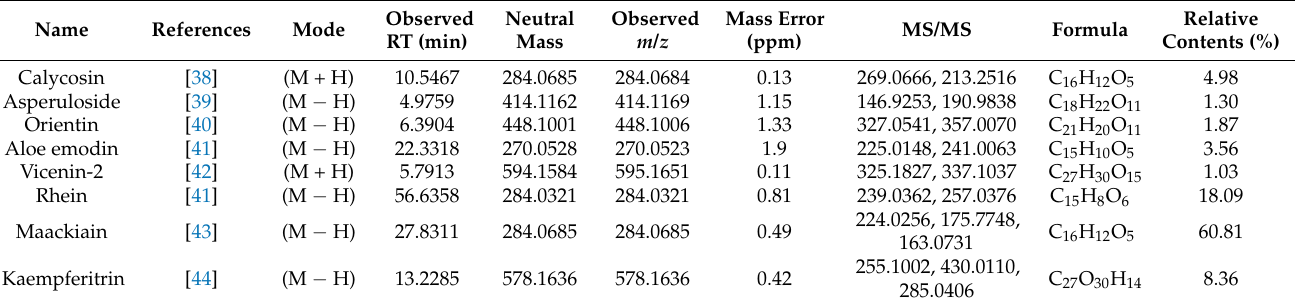
Table 2. Phytochemical analyses and identified compound profiles in HSF of KR.